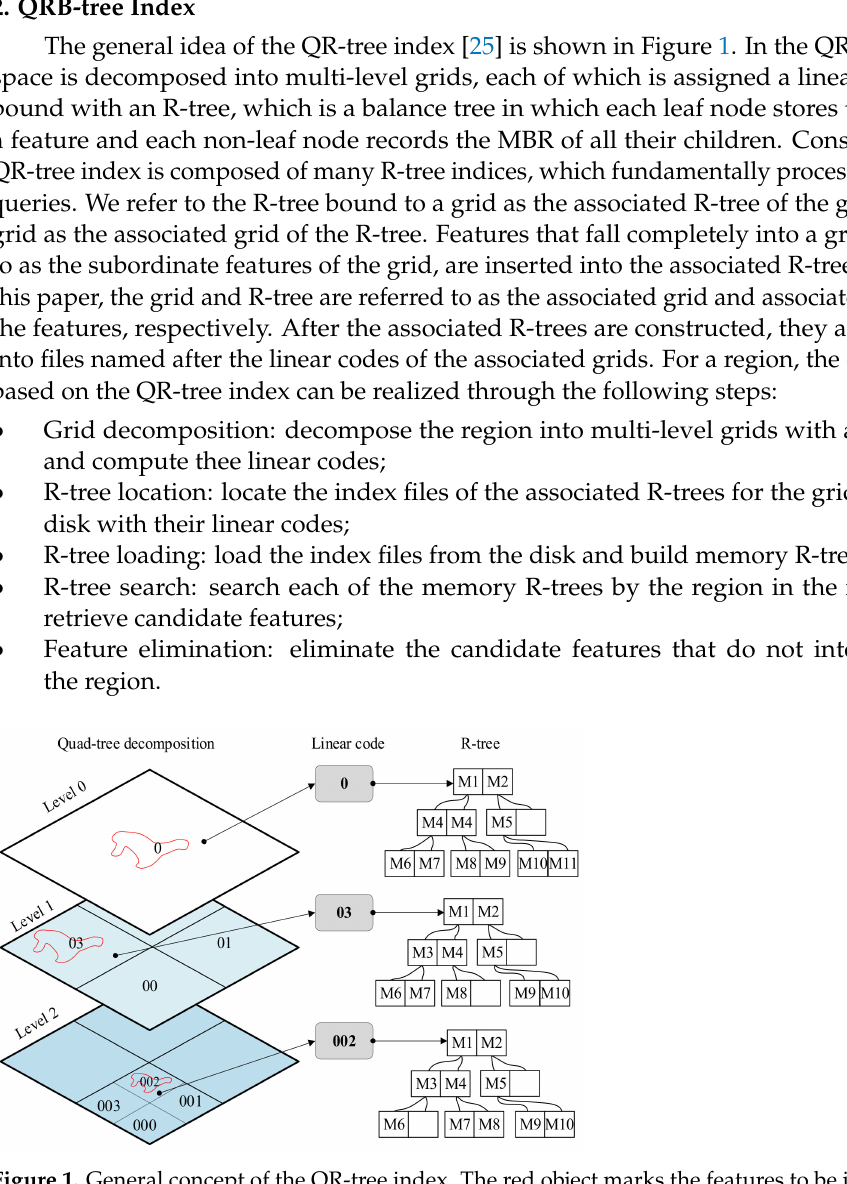
Figure 1. General concept of the QR-tree index. The red object marks the features to be indexed. The features are first assigned to grids of different levels according to their locations and extents.